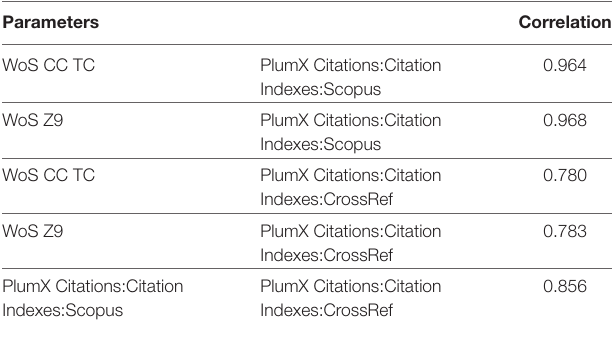
Table 9 | Citation correlations Web of Science (WoS) TC and ZA versus PlumX- Scopus/CrossRef ( n = 4,233; all publication years). Parameters